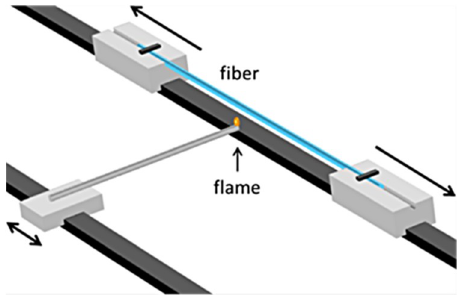
Figure 1. Schematic representation of a typical fiber tapering rig.